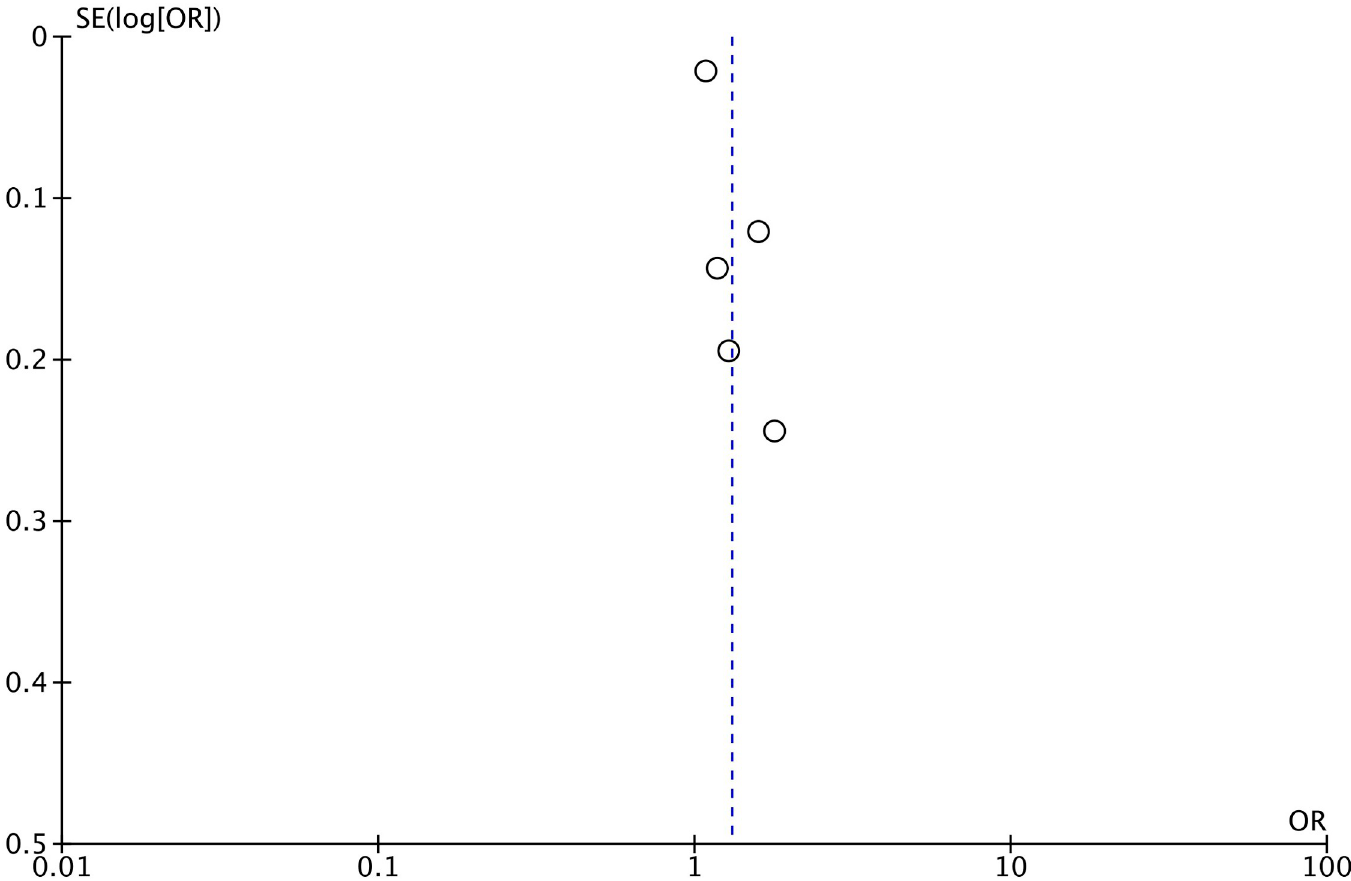
Fig 3. Funnel plot of the meta-analysis of the association between hypoalbuminemia and mortality after CRRT.